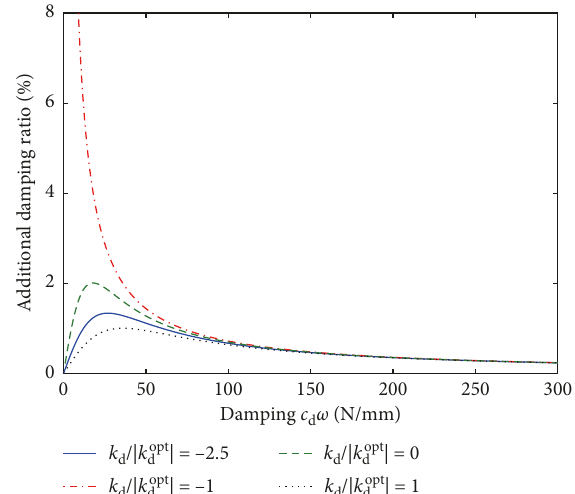
Figure 15: Additional modal damping ratio for the stay cable with various levels of